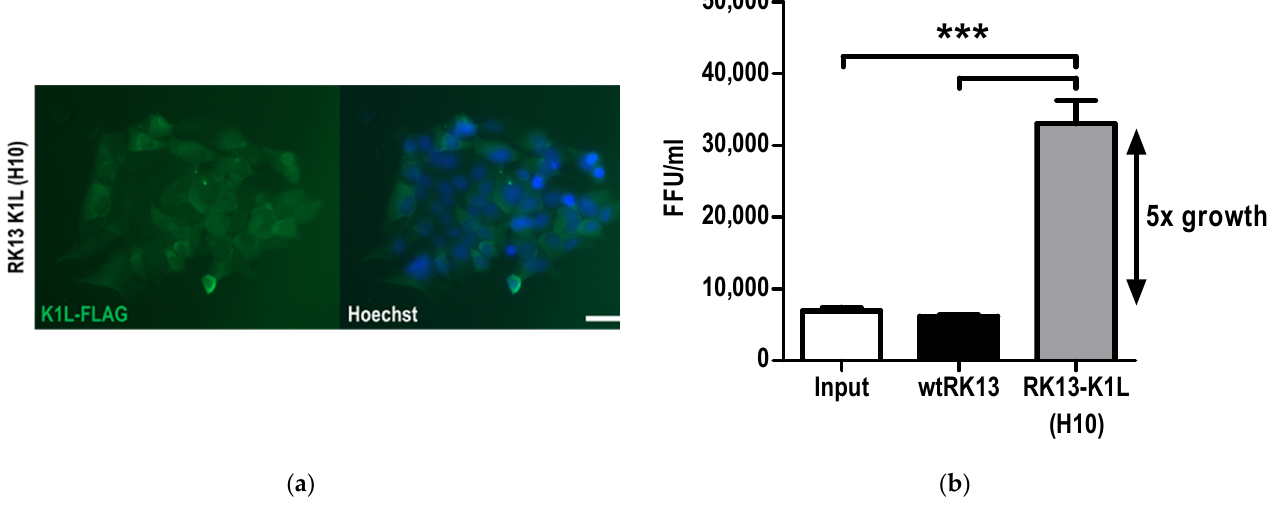
Figure 6. Generation of RK13 cells with stable expression of VACV K1L to rescue growth of LSDV. ( a ) Immunofluorescence showing expression of K1L by the clonal cell lineRK13-K1L(H10); K1L expression was detected by probing for the C-terminal Flag-tag present in the transgene. Scale bar = 100µm. ( b ) Growth of LSDVGC5 in the RK13-K1L(H10) cell line as compared to wildtype RK13 three days post infection. *** p < 0.001.